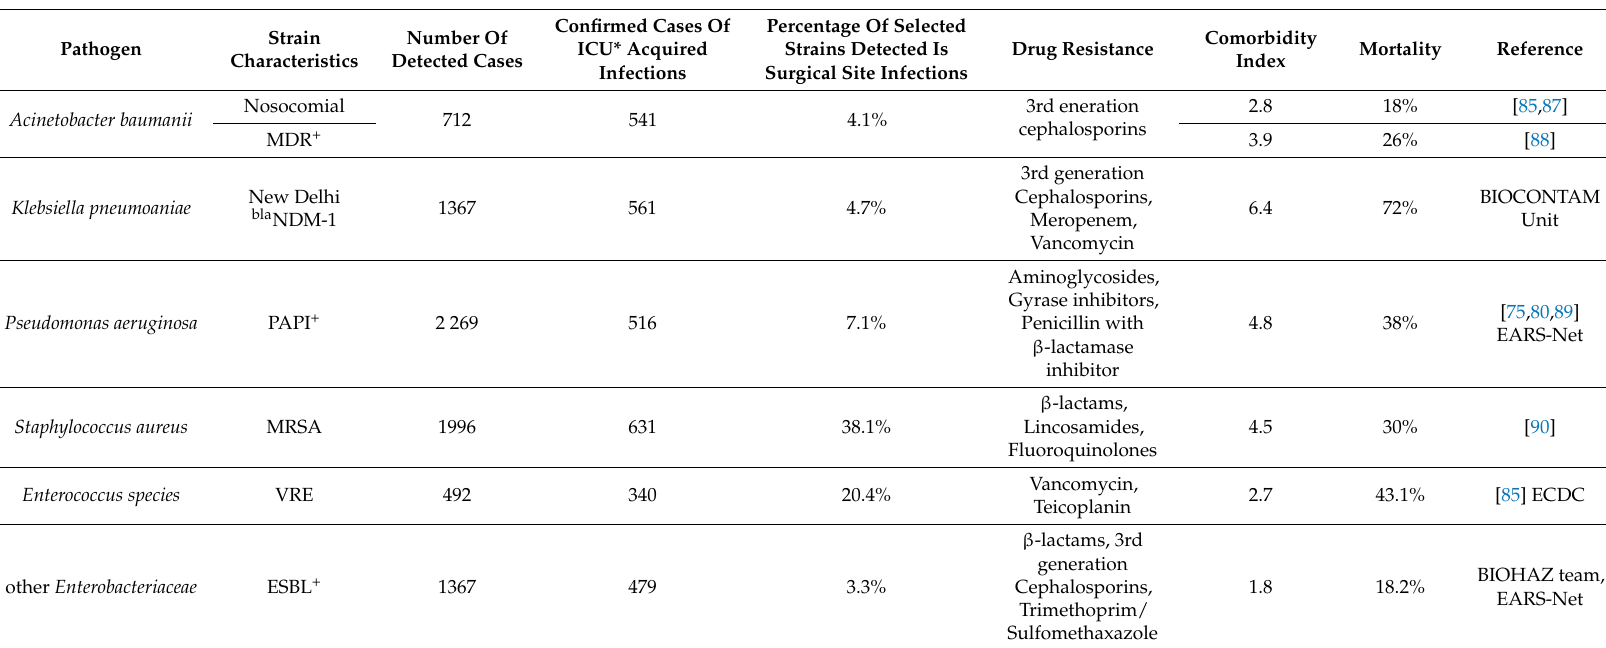
Table 1. Morbidity, number of hospitalizations and mortality due to selected bacterial infections with priority pathogens causing blood stream infections in people in the European Union countries in